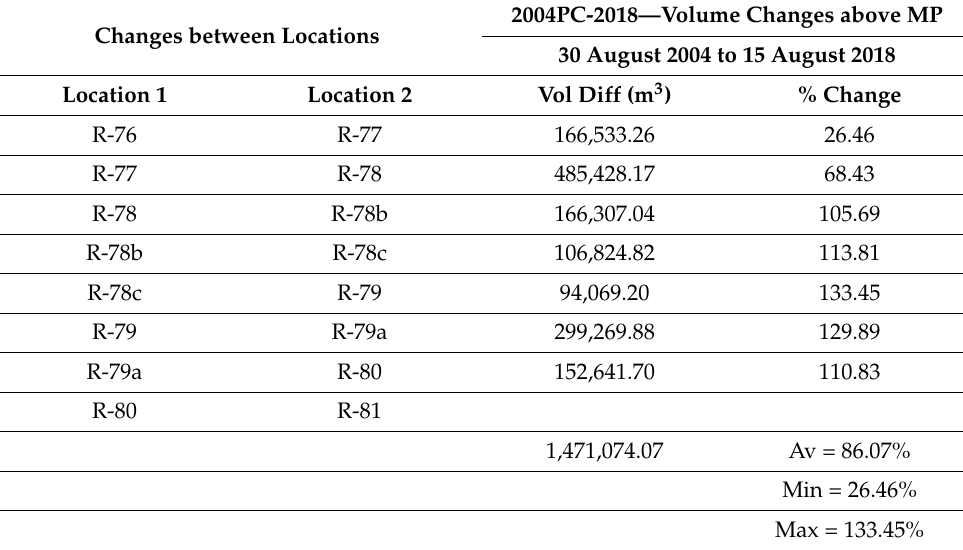
Table 2. Sediment volume calculations between R-monuments in the southern portion of North Captiva Island for 2004 to 2018. See Table 1 caption for the master profile (MP)